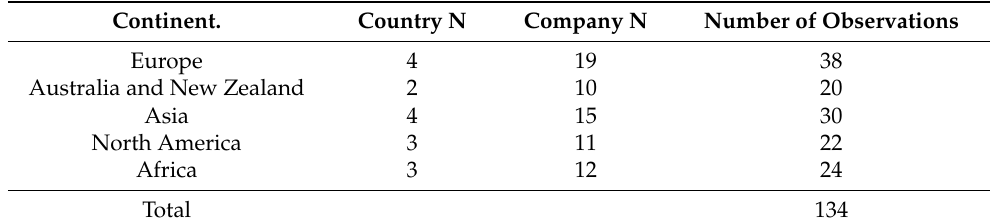
Table 2. Number of observations.